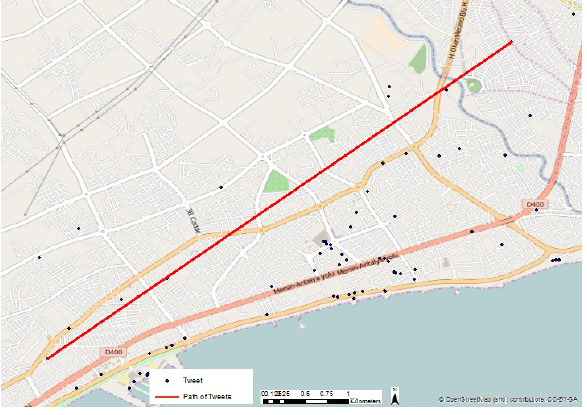
Figure 8. Driver Travel Length within a Reliable Time